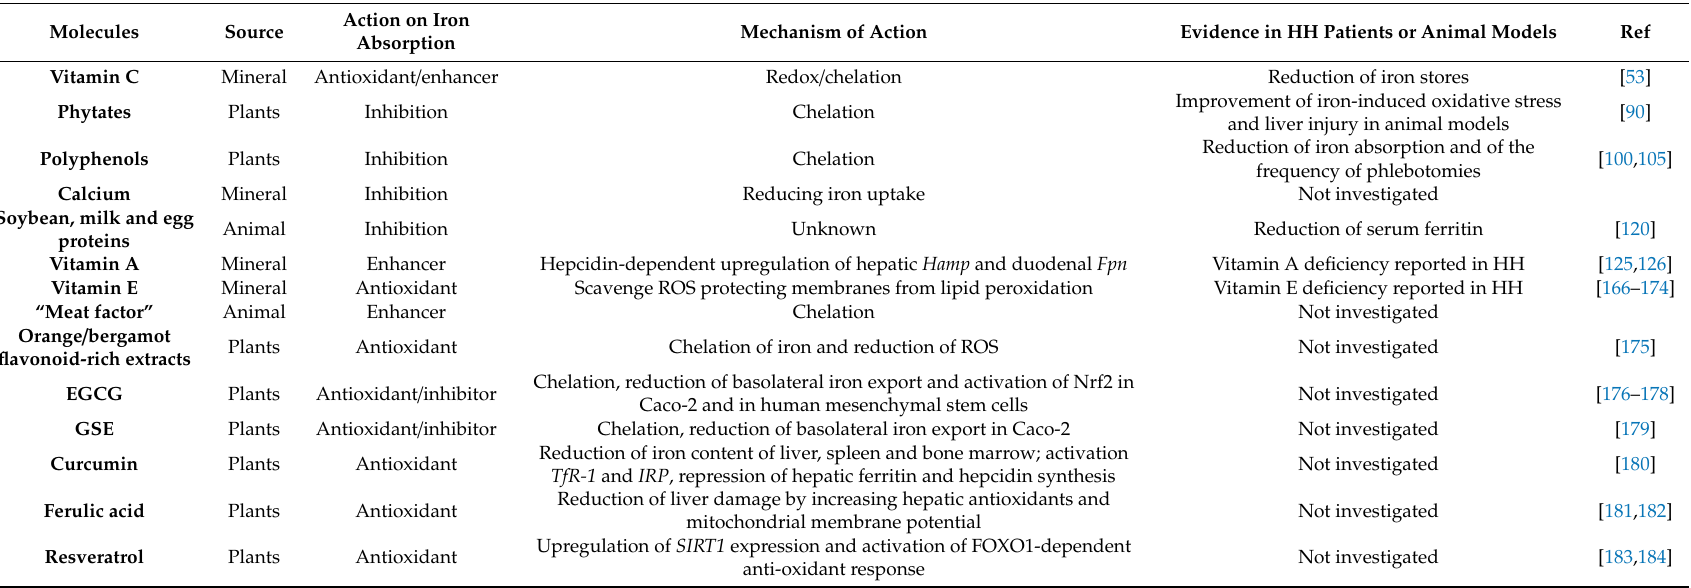
Table 1. Dietary bioactive molecules and their impact on iron